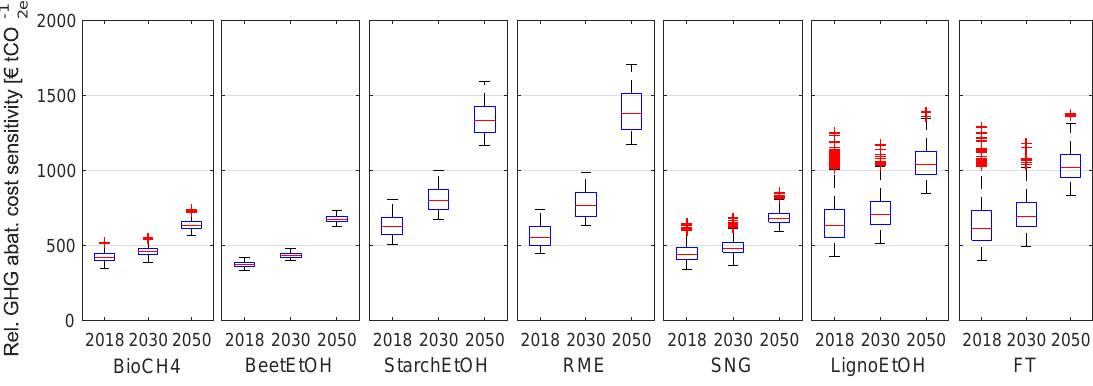
Figure 9. Sensitivity of total cost of the GHG abatement of biofuels in 2018, 2030 and 2050 in Sensitivity Case 1B (corresponding to the base scenario (a)), at a constant annual 4% wheat price increase and the other variables randomly varied according to Section 2.4. The red lines show the median; the bottom and top edges of the blue box show the 25th and 75th percentiles, respectively; the whiskers extend to a maximum of 1.5-times the length of the box; and outside of this interval, outliers are plotted with a red